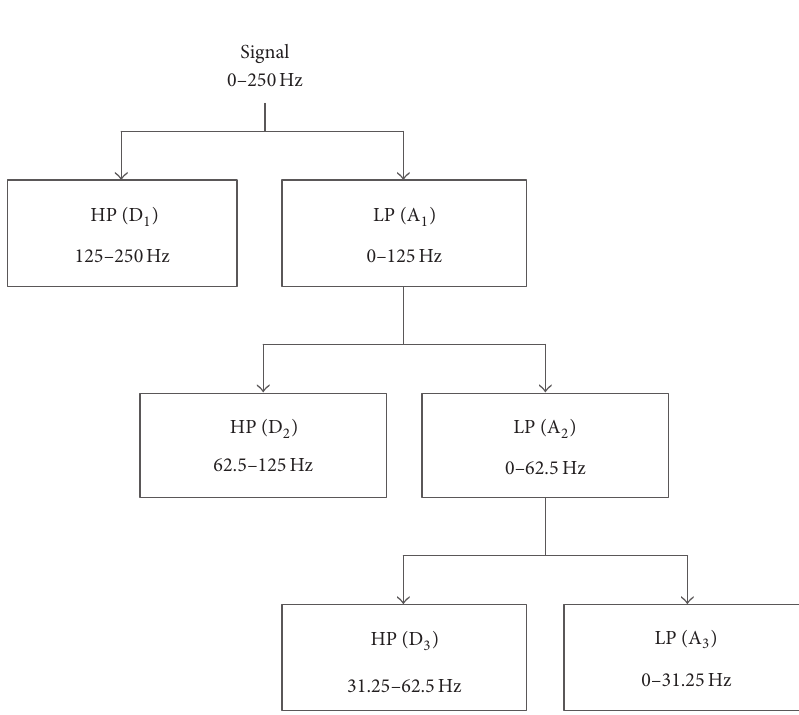
Figure 3: The structure of the three-level DWT of EEG signal.